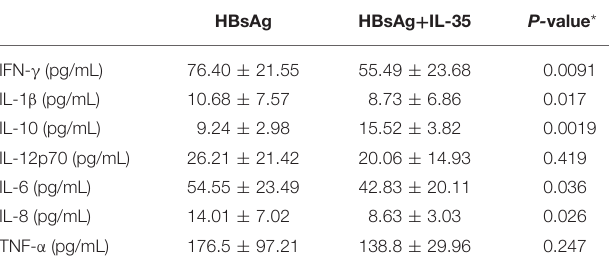
TABLE 2 | Cytokine production by PBMCs in response to IL-35 stimulation. HBsAg HBsAg + IL-35 P- value